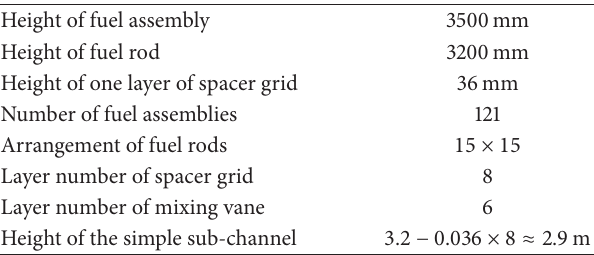
Table 4: Parameters of nuclear power plant of Qinshan